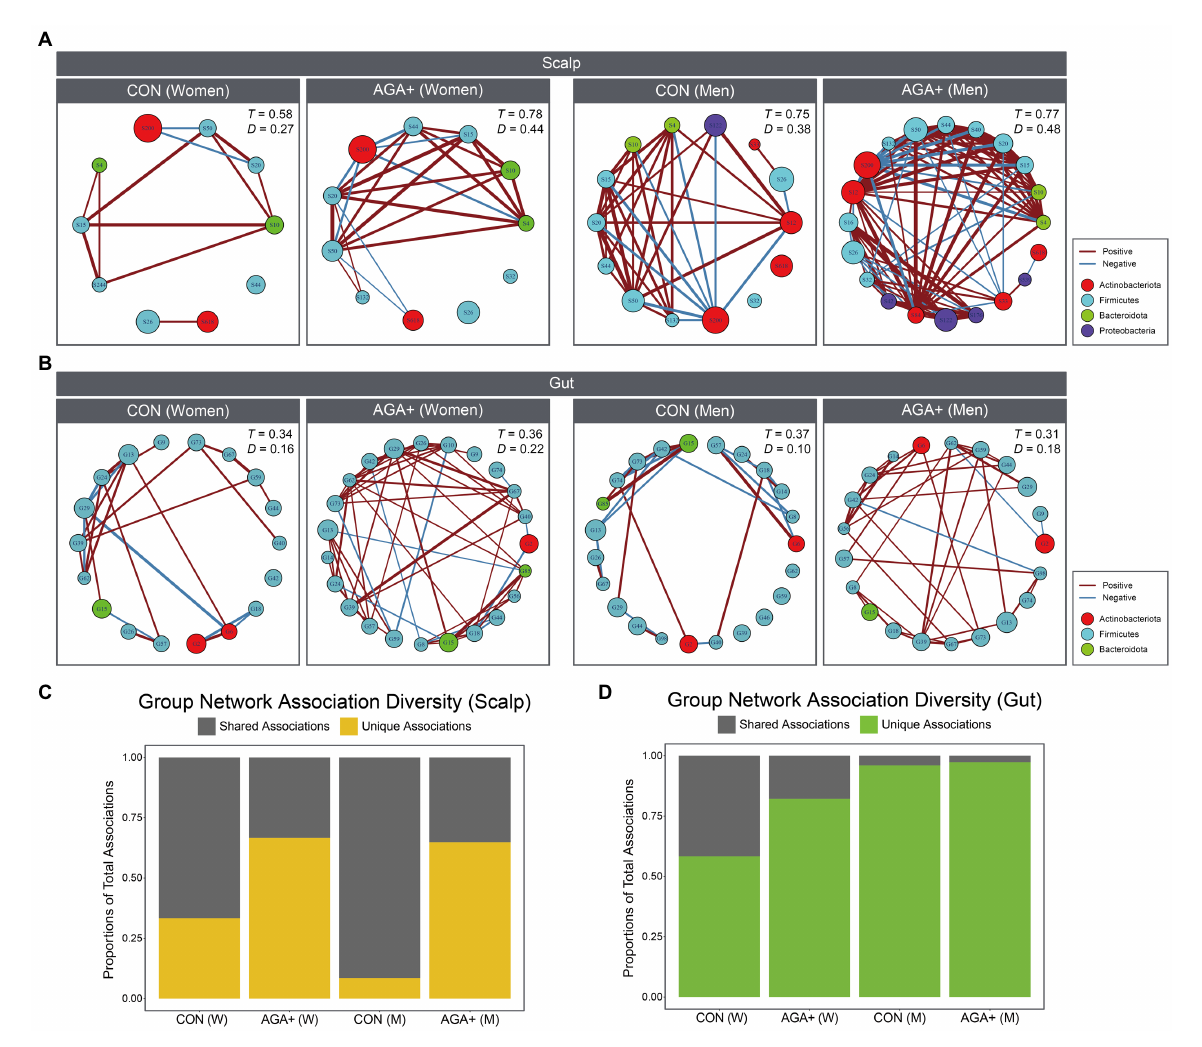
FIGURE 6 Bacterial association networks of scalp (A) and gut (B) microbiome at the genus level. Nodes indicate genera, and the size of each node represents the relative abundance. Edge color (red or blue) represents positive or negative correlations, respectively. The T and D values represent the transitivity and density of the network, respectively. The portion of associations within networks of each group that are unique or shared in scalp (C) and gut (D) microbiome. W and M are abbreviations for women and men,